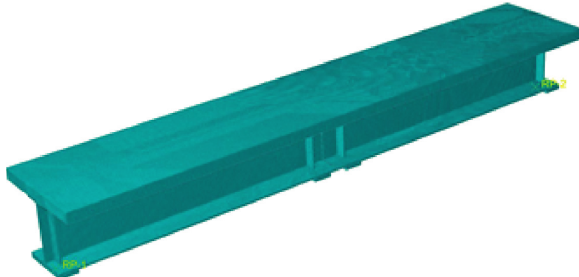
Figure 9: Model of the composite